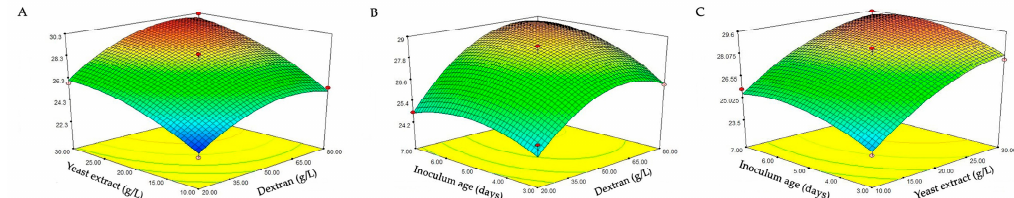
Figure 2. Response surface plots for the interactions between the independent variables. ( A ): E ff ect of yeast extract (g / L) and dextran (g / L); ( B ): E ff ect of inoculum age (days) and dextran (g / L); ( C ): E ff ect of inoculum age (days) and yeast extract (g / L). The values in the figure indicated the level of dextranase enzyme activity (unit /